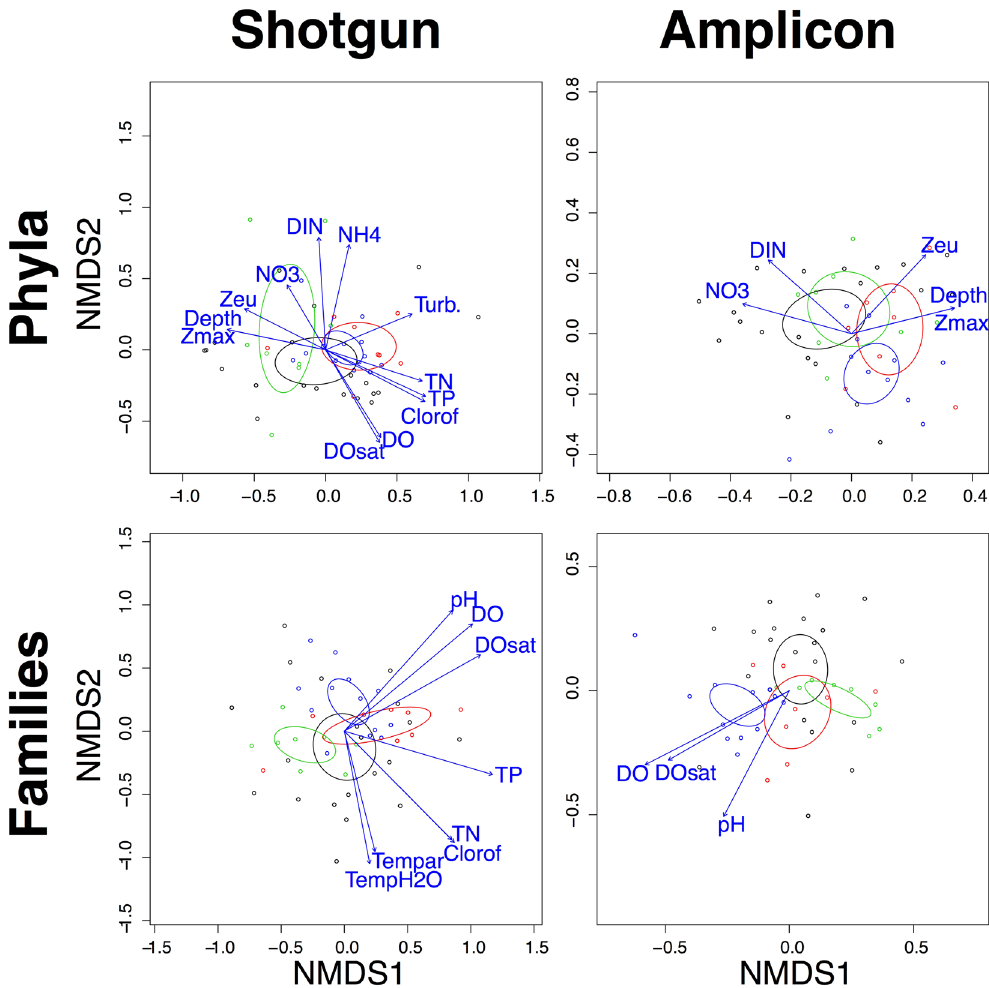
Figure 5. NMDS plots for datasets from the shotgun and amplicon techniques for the family and phylum level. Color codes for sites and confidence ellipses are as follows: black = Amazon, red = Araguaia, green = Pantanal, and blue = Paraná. Blue arrows indicate environmental variables that correlate to ordinations. See Supplementary Table 1 for a list of expanded environmental variable